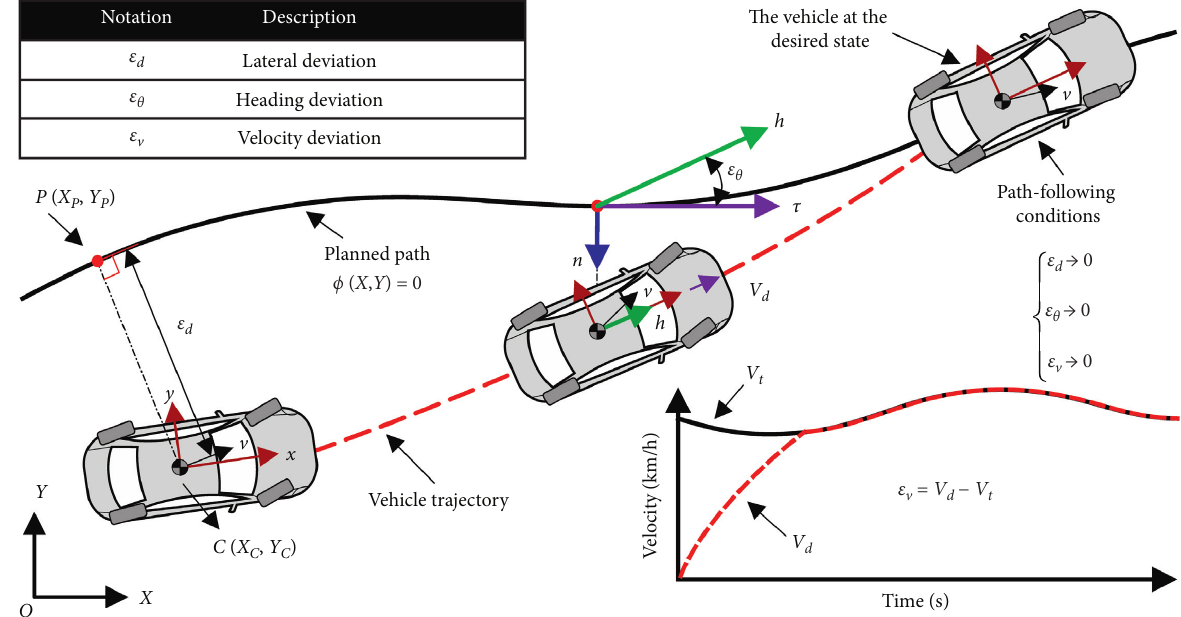
Figure 2: Path following deviations of the vehicle in current state from its desired